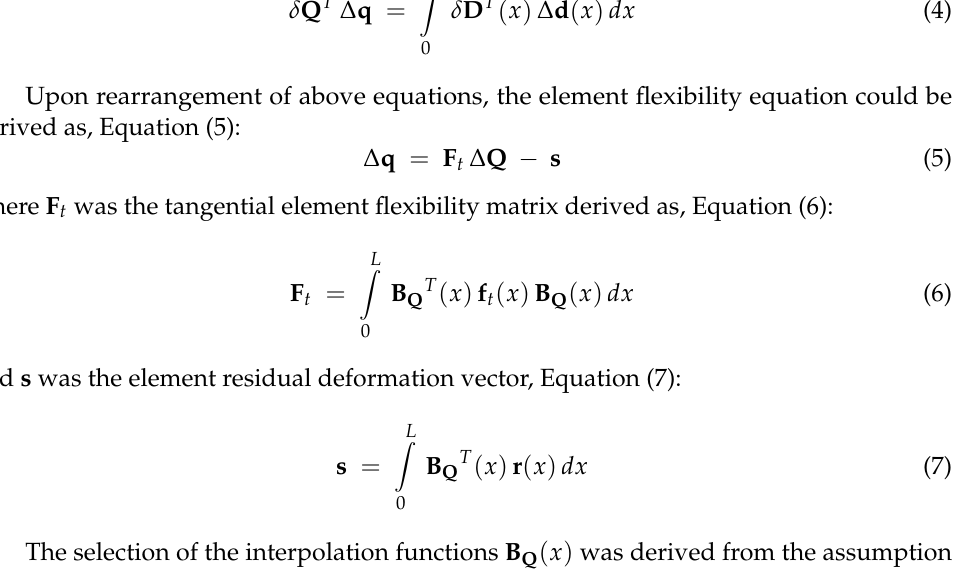
The selection of the interpolation functions B Q ( x ) was derived from the assumption of constant axial force and linear bending distributions within the element. Finally,